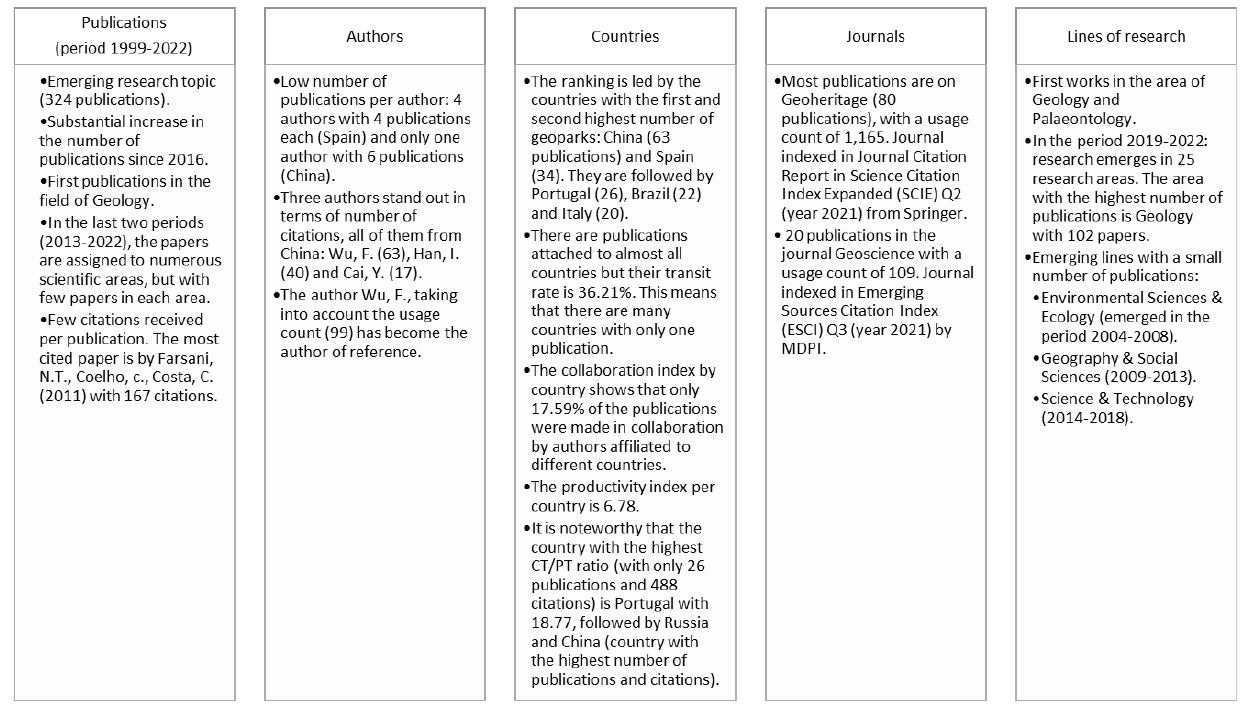
Figure 6. Summary results.